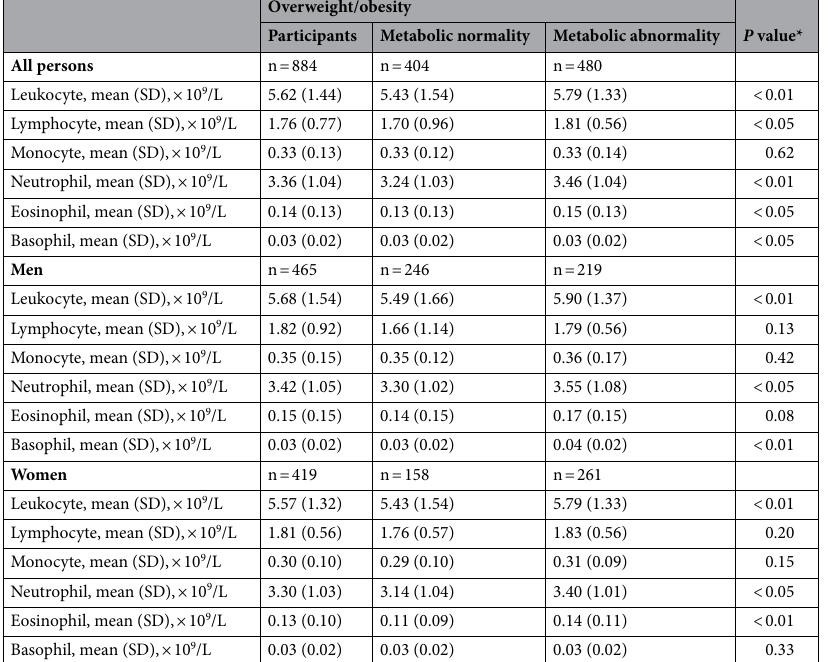
Table 2. Leukocyte-related parameters of study participants by metabolic status. * P values represent difference in characteristics by metabolic syndrome status based on analysis of